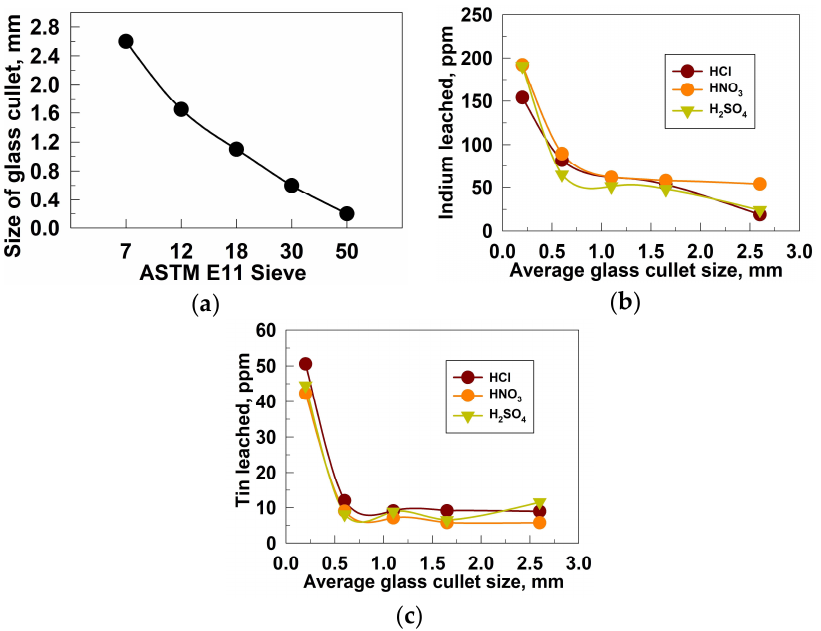
Figure 6. ( a ) Average sizes of the glass cullet pieces per different sizes of ASTM E11 sieves; ( b ) Relationship between indium leaching and cullet piece size; and ( c ) Relationship between tin leaching and cullet piece size.